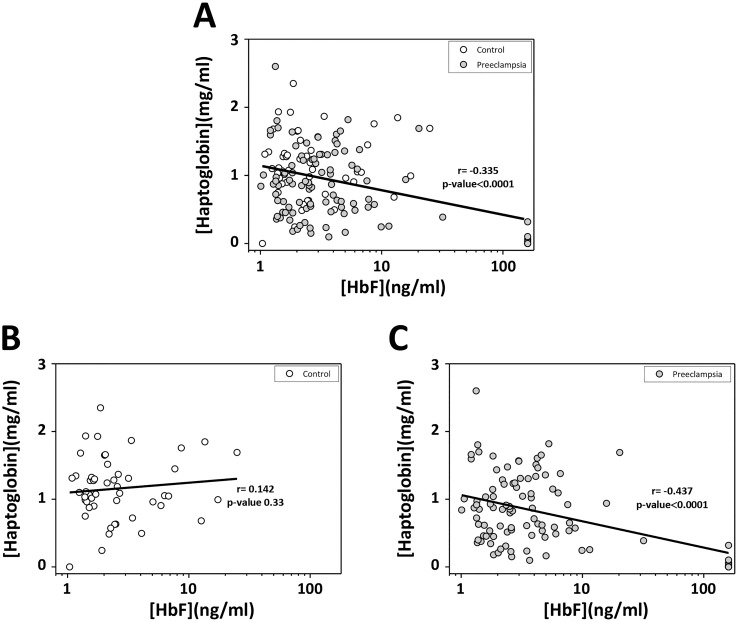
Correlation between cell-free HbF- and Hp concentrations.Samples were from normal pregnancies (Control) and women diagnosed with PE. The cell-free HbF plasma concentration of each patient sample (Control and PE) was plotted against the Hp plasma concentration (A). The cell-free HbF plasma concentration of Controls was plotted against the Hp plasma concentration (B). The cell-free HbF plasma concentration of women diagnosed with PE was plotted against the Hp plasma concentration (C). Associations between variables were assessed by linear regression analysis (Pearson’s).